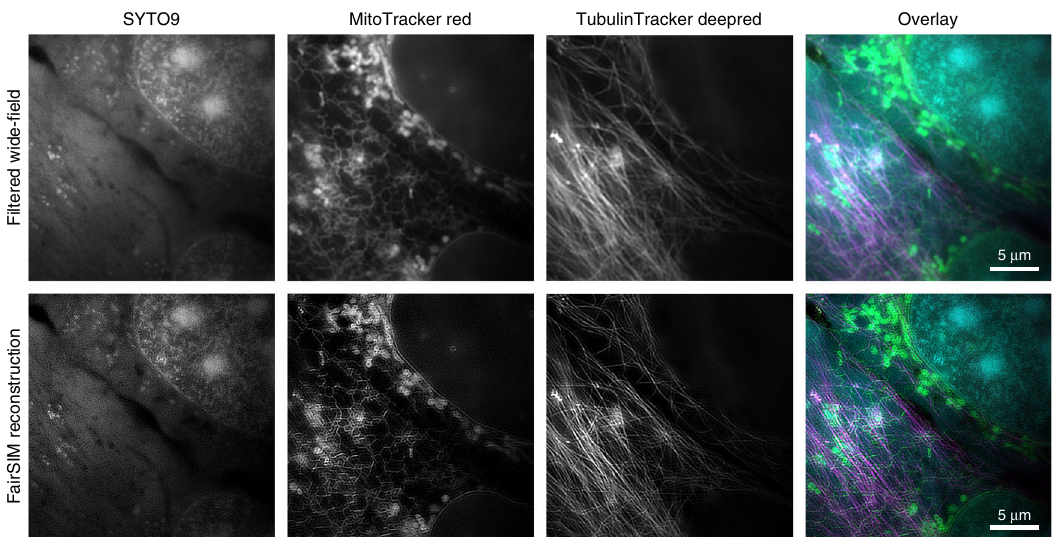
Fig. 6 Demonstration of three-color live-cell imaging. These images were acquired with 10 ms raw frame exposure time and 2.4 (time lapsed) multicolor SIM frames per second. Live U2OS cells were stained for nucleic acids with SYTO 9, mitochondria and endoplasmic reticulum with MitoTracker Red, and polymerized tubulin fi laments with Tubulin Tracker Deep Red. The individual channels and an overlay of all three channels (SYTO 9 in cyan, MitoTracker Red in green, and Tubulin Tracker Deep Red in magenta) are shown as reconstructed Wiener fi ltered wide- fi eld and FairSIM images, respectively. The scale bar in the overlay images represents 5 µ top-phase alignment (matching the axial pattern repetition to the detection focal plane).